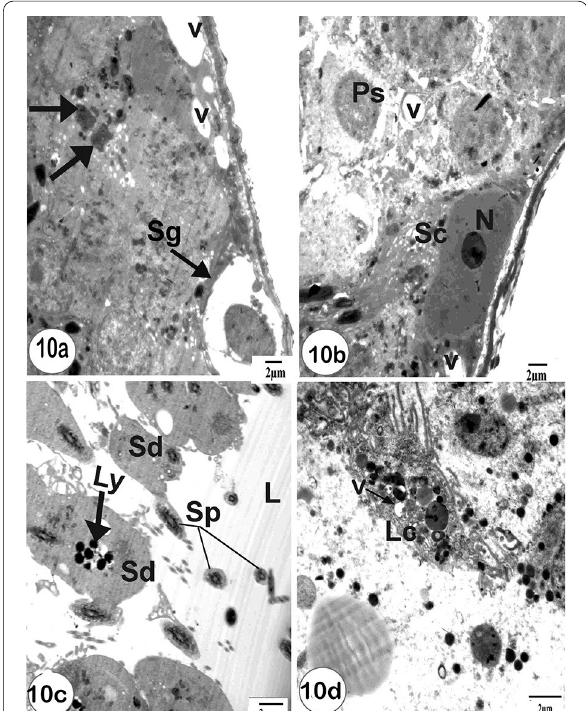
Fig. 10 An electron micrograph of sections of testis of MSG‑treated rats showing a vacuolation in spermatogenic cells (v), autolysis in spermatogonia (Sg) and primary spermatocytes (Ps) with damaged nucleus and fragmented chromatin (arrows) (scale bar 2 µm), b = Sertoli cell (Sc) and primary spermatocytes (Ps) with vacuolation Fig. 11 An electron micrograph of a sections of testis of (v) (scale bar 2 µm), c spermatids (Sd) with active lysosomes (Ly), MSG‑intoxicated rats treated with quercetin showing a basal lamina = degenerated nucleus and marked decrease in number of sperms (Sp) (Bm) of seminiferous tubules, primary spermatocytes (Ps) with normal in lumen (L) of seminiferous tubules (scale bar 2 µm) and (e) Lydeig large spherical nuclei and Sertoli cells (Sc) having triangular nucleus = cells with abnormal nucleus and vacuolation (v) (scale bar 2 µm) (Scale bar 2 µm), b normal round spermatids (Sd) with spherical = = nucleus (Scale bar 2 µm), c cross section of sperms’ tails (Sp) at the = level of mid piece and normal spermatids (Sd) (Scale bar d Leydig cell (Lc) with normal nucleus (N) and lipid droplets (Li) (Scale bar 2 =